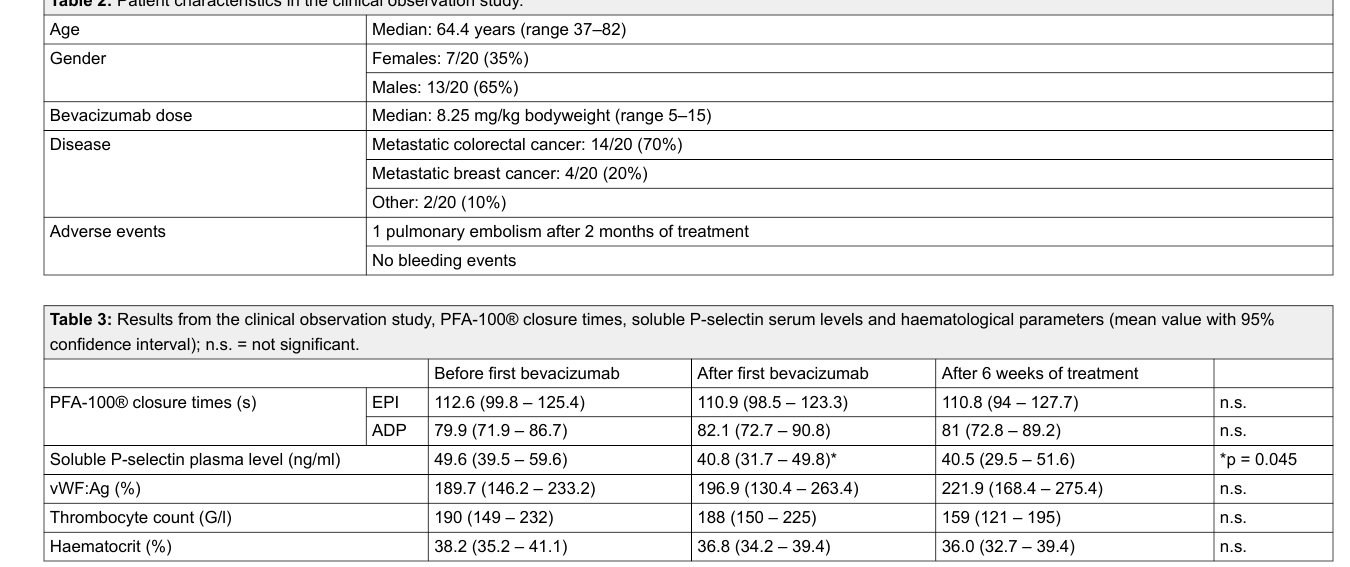
Table 2: Patient characteristics in the clinical observation study. Age